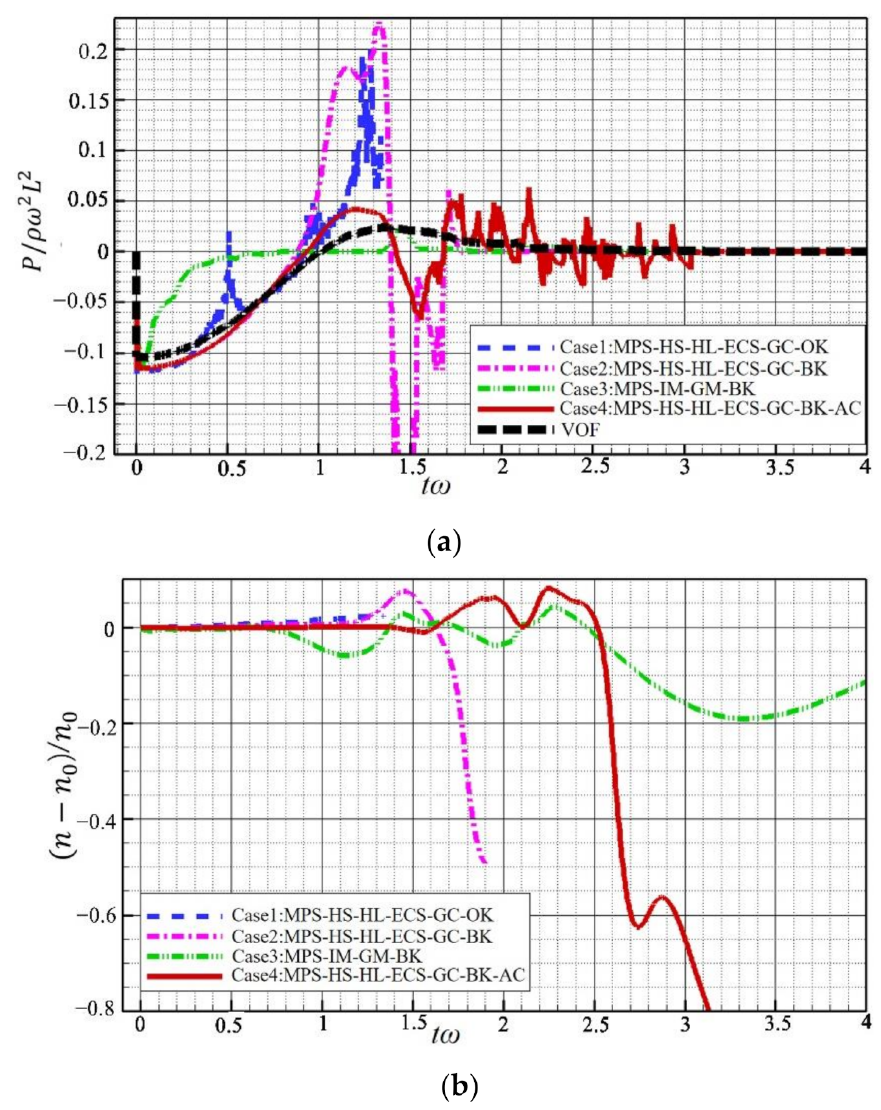
Figure 9. Time histories of the pressure and particle number density of a particle initially located at the center of the cubic fluid patch: ( a ) pressure; ( b ) particle number